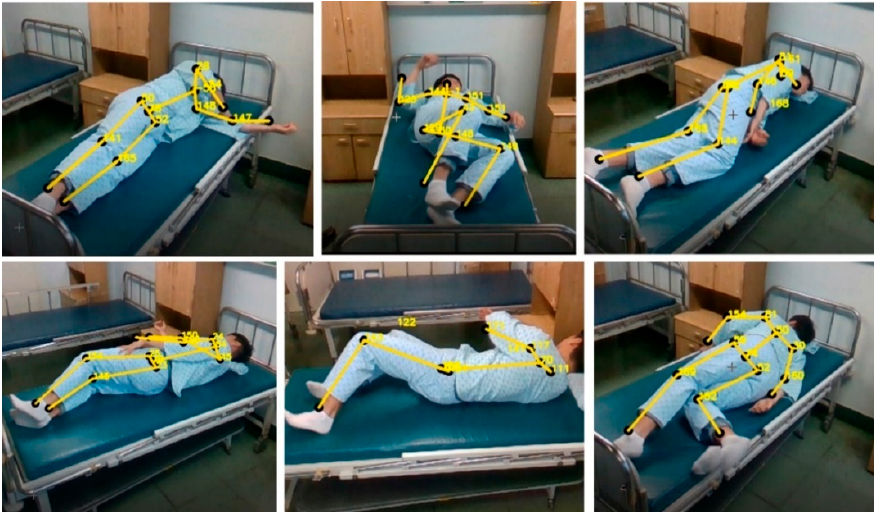
Figure 15. Measurement image of the motion of rotating the body while lying down.